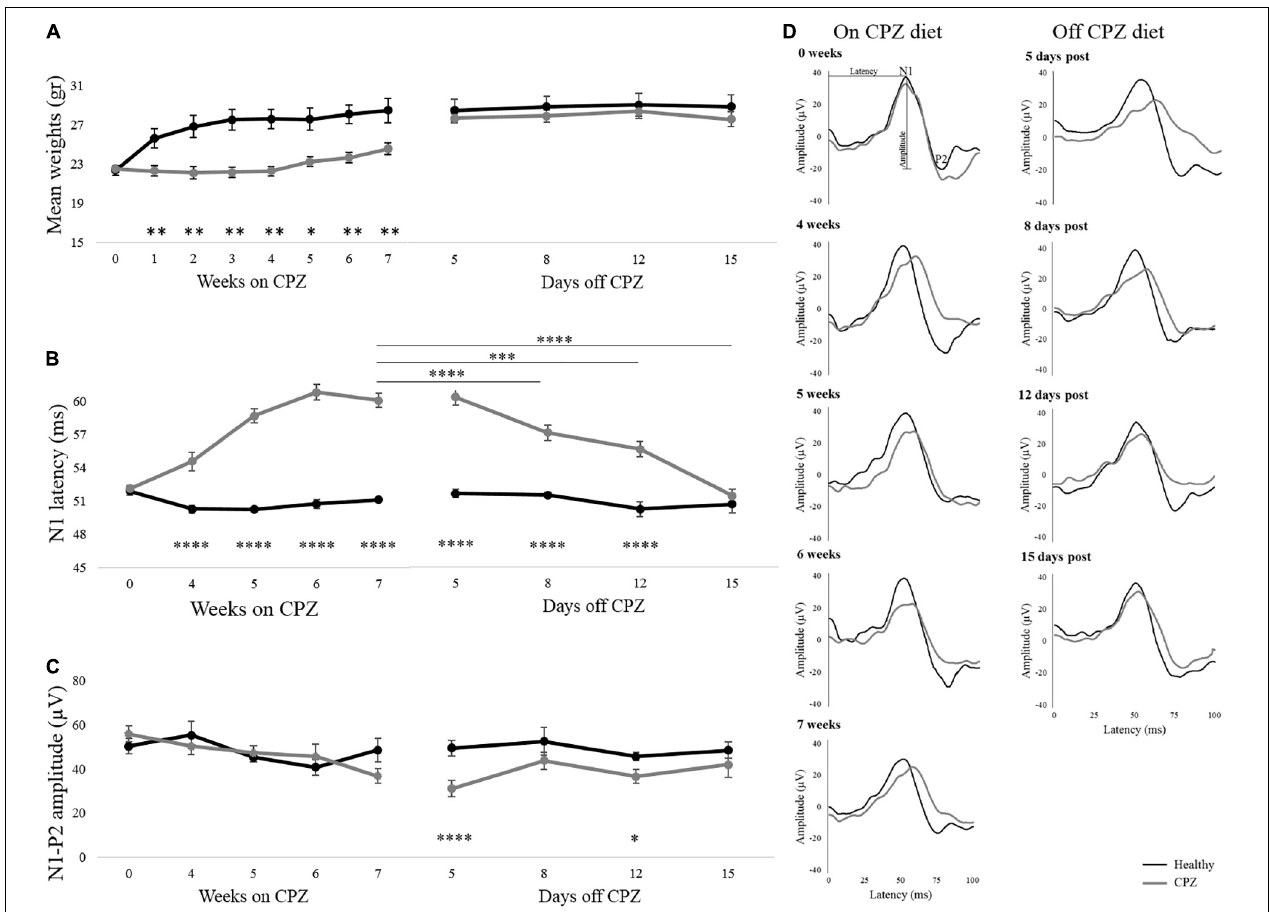
FIGURE 2 | Body weights and VEPs response. (A–C) Mean body weights, N1 latency, and N1-P2 amplitude detected during the week on CPZ diet and days off CPZ diet. (D) Representative VEP waveforms of one single mouse for each group were represented during on CPZ diet (0, 4, 5, 6, and 7 weeks) and off the CPZ diet (5, 8, 12, and 15 days post). Black lines represent Healthy mice ( n = 6 mice/12 eyes), dark gray lines represent cuprizone mice ( n = 9 mice/18 eyes). The error bars represent the SEM. Two-way ANOVA for repeated measures followed by LSD post hoc test * p < 0.05; ** p < 0.01; ∗∗∗ p < 0.001 and ∗∗∗∗ p < 0.0001.